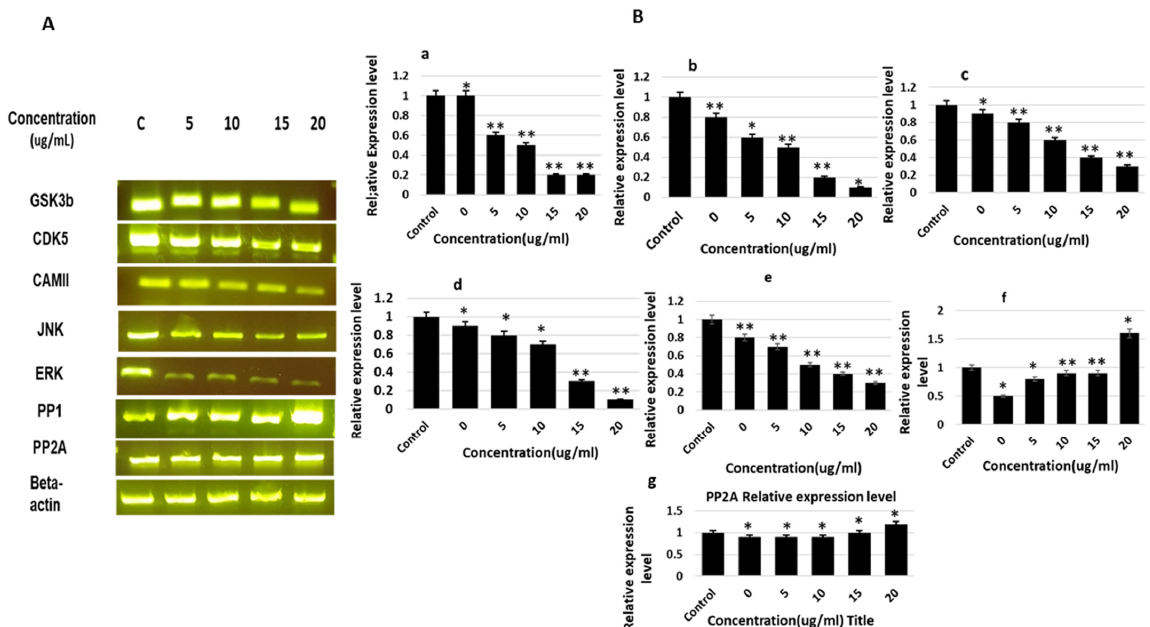
Figure 4. mRNA expression levels of various kinases and phosphatases involved in tau phosphory- lation and dephosphorylation, determined by RT-PCR. ( A ). PCR products of mRNA expression of various genes of the kinases and phosphatases presented in gel band form after gel electrophoresis. ( B ). Relative mRNA expression levels of genes of various kinases and phosphatases after treatment with theasaponin E1. ( a ) Relative mRNA expression levels of GSK3 beta. ( b ) Relative mRNA expres- sion levels of CDK5. ( c ) Relative mRNA expression levels of JNK. ( d ) Relative mRNA expression levels of ERK. ( e ) Relative mRNA expression levels of CAMII. ( f ) Relative mRNA expression levels of PP1. ( g ) Relative mRNA expression levels of PP2A. ( h ) mRNA expression levels of genes of var- ious kinases and phosphatases that were visualized as PCR products on agarose gel. Data are the mean values ± SEM and were analyzed using one-way ANOVA ( n = 3). Data are statistically signif- icant at p < 0.05 (* p < 0.05; ** p < 0.01 to the control group).